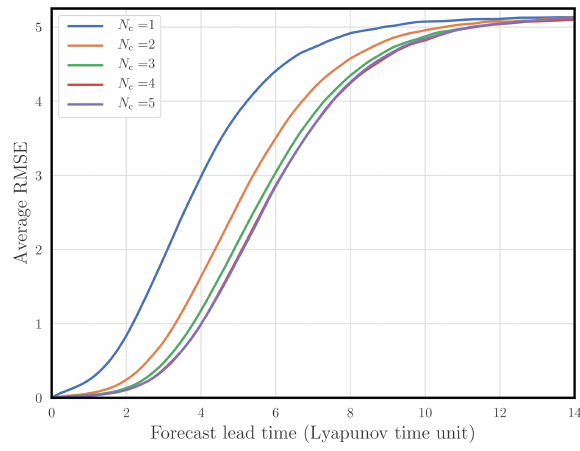
Figure 3. Average RMSE of the surrogate model (L96 with an RK2 structure) compared to the reference model (L96 with an RK4 inte- gration scheme) as a function of the forecast lead time (in Lyapunov time unit) for an increasing number of